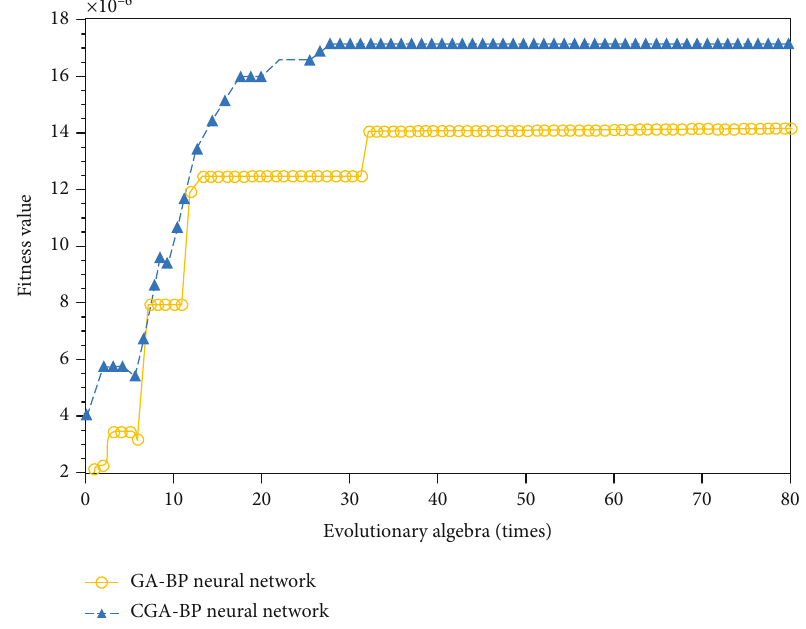
Figure 9: Comparison of iteration times of genetic algorithm under di ff erent